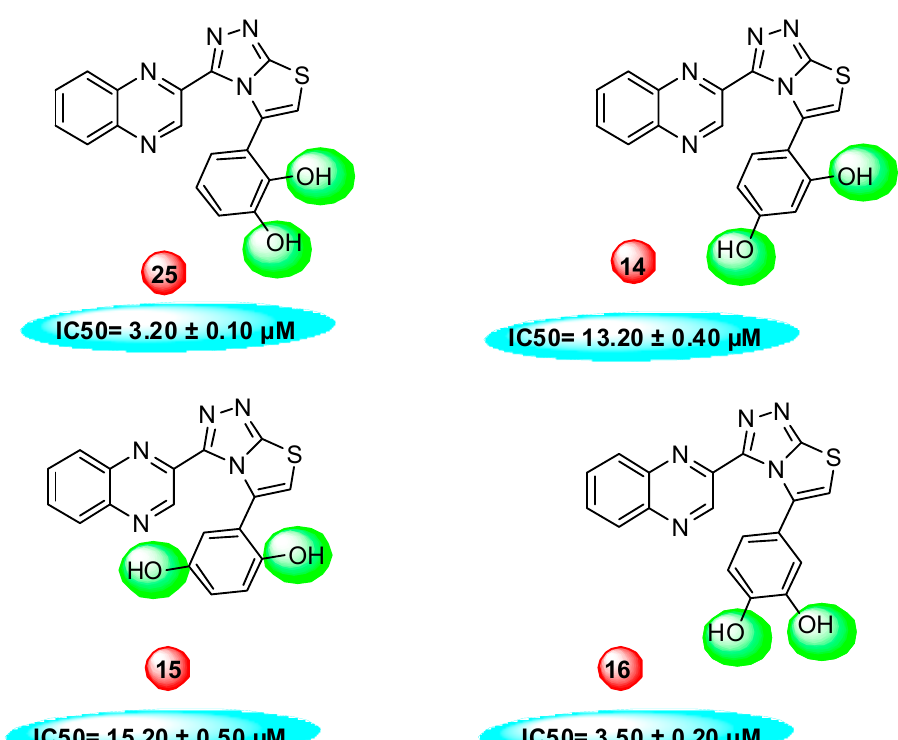
Figure 2. Dihydroxy substitutions at different positions affect their activity.